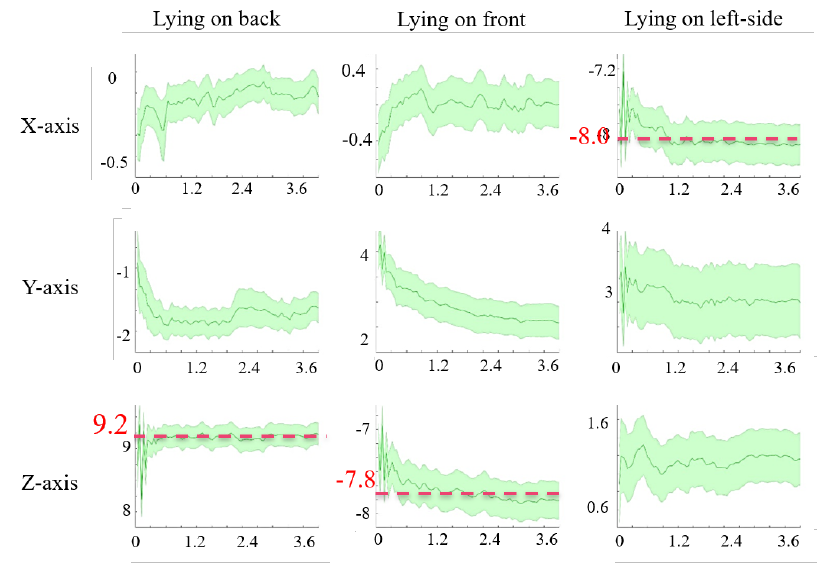
Figure 4. Mean and standard deviation of the magnitude of the accelerometer sensor data for different lying postures over all the subjects.